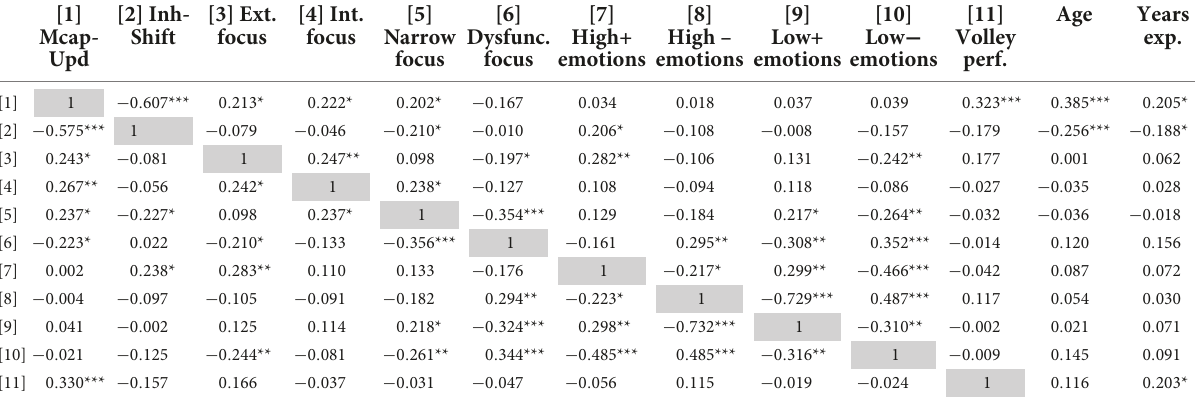
TABLE 5 Zero-order and partial correlations between predictors and the volleyball players’ performance.